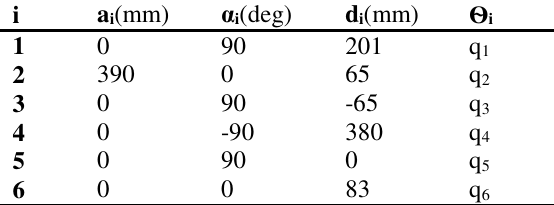
Fig. 2. The Attached Coordinate Frame Systems. Table 1, DH Parameters of the Robot